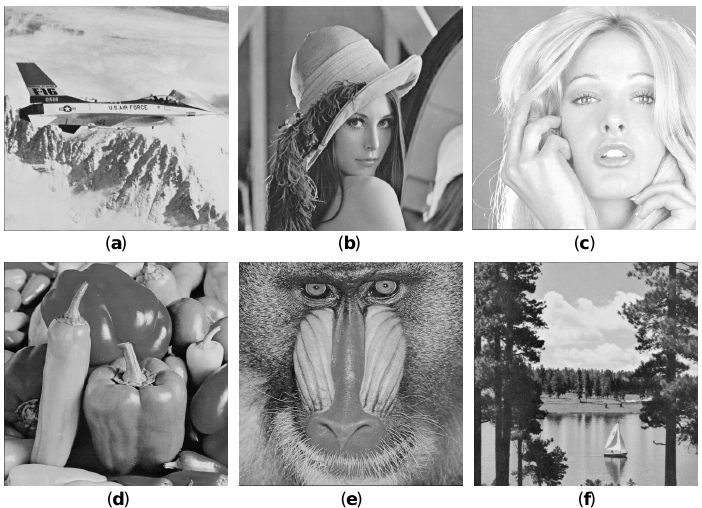
Figure 5. Six standard test images with a size of 512 × 512: ( a ) Airplane , ( b ) Lena , ( c ) Tiffany , ( d ) Peppers , ( e ) Baboon , and ( f ) Sailboat